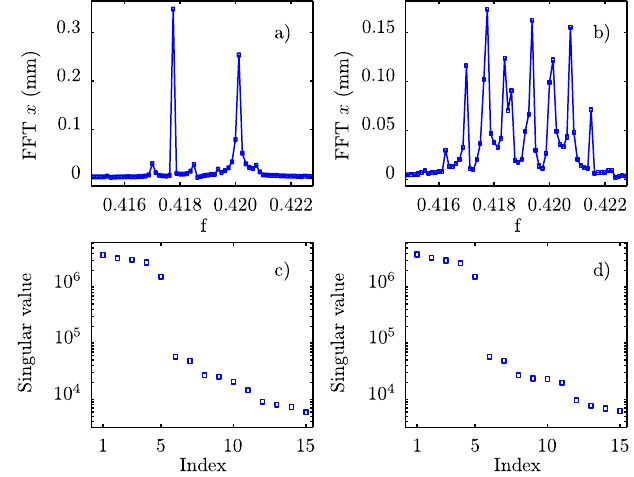
FIG. 1. Fourier amplitudes and singular values for single particle experiencing betatron and synchrotron oscillations in the Tevatron. Beam history matrix B was obtained via tracking simulation in ELEGANT [19] using two different sextupole set- tings corresponding to small and large chromaticities. For (a) and (c) (cid:4) x ¼ (cid:1) 3 , (cid:4) y ¼ 3 ; for (b) and (d) (cid:4) x ¼ 19 , (cid:4) y ¼ 26 . Initial nonzero particle coordinates are x 0 ¼ 6 (cid:2) 10 (cid:1) 6 and ¼ 4 (cid:2) 10 (cid:1) 5 (cid:2) p=p 0 where X ¼ ð x; p x ; y; p y Þ T is the vector of particle canonical coordinates in transverse phase space, R ð s Þ is the 4 (cid:2) 4 transport matrix along the ring from location 0 to location ; D ; D ; D Þ T is the vector dispersion s , D ð s Þ ¼ ð D x p x y p y is the relative momentum function, and (cid:2) ð t Þ ¼ (cid:2) p ð t Þ =p 0 deviation performing slow synchrotron oscillations (i.e., the synchrotron tune (cid:3) s (cid:5) 1 ). ð t Þ (cid:3) X ð 0 ; t Þ (cid:1) D ð 0 Þ (cid:2) ð t Þ Although the exact form of X 0